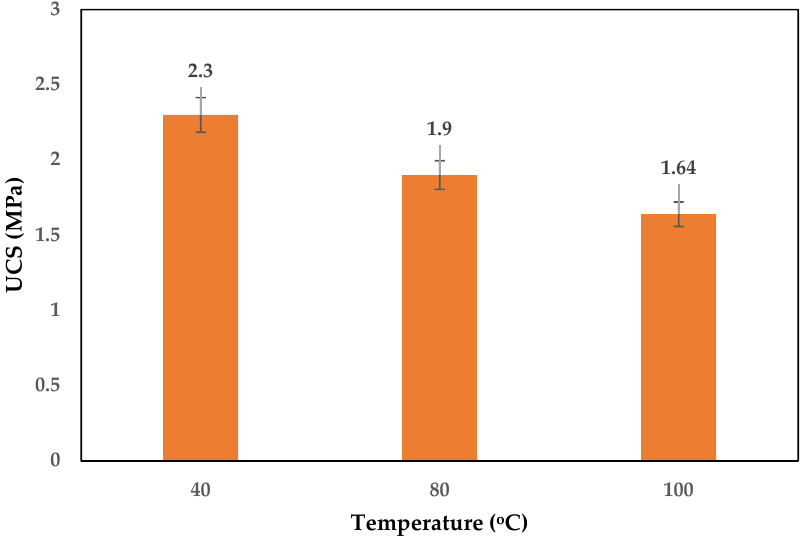
Figure 12. UCS of WFGD gypsum bricks at various curing temperatures.